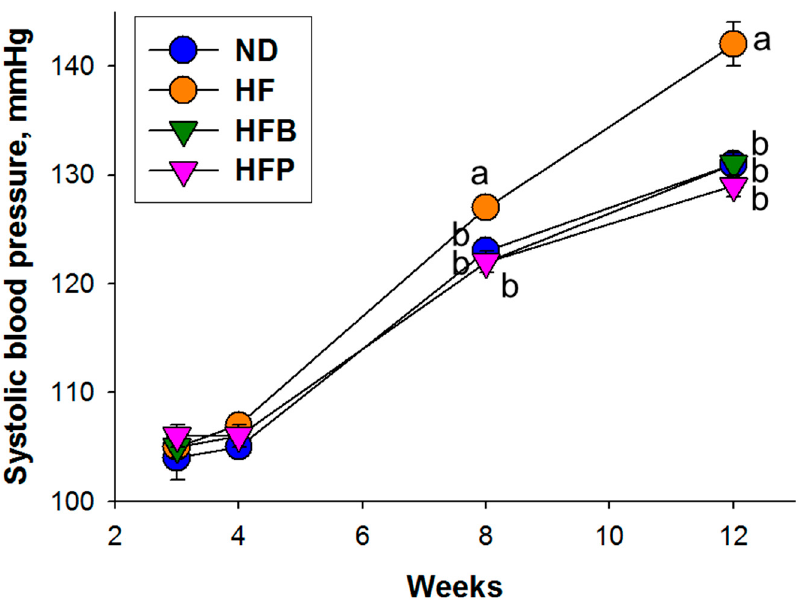
Figure 1. Systolic BP of male offspring at 3 to 12 weeks of age. n = 8/group; the letters represent the